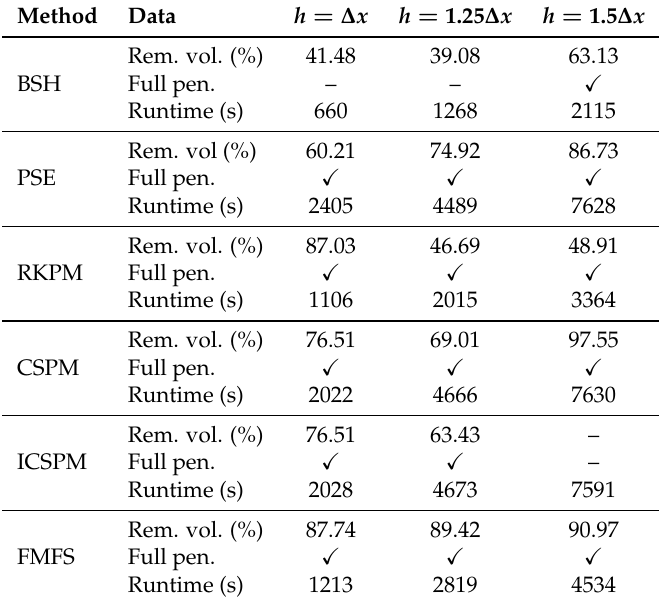
Table 6. Batch 4: Fine discretization using a total of 203k particles with the Wendland quintic kernel. Method